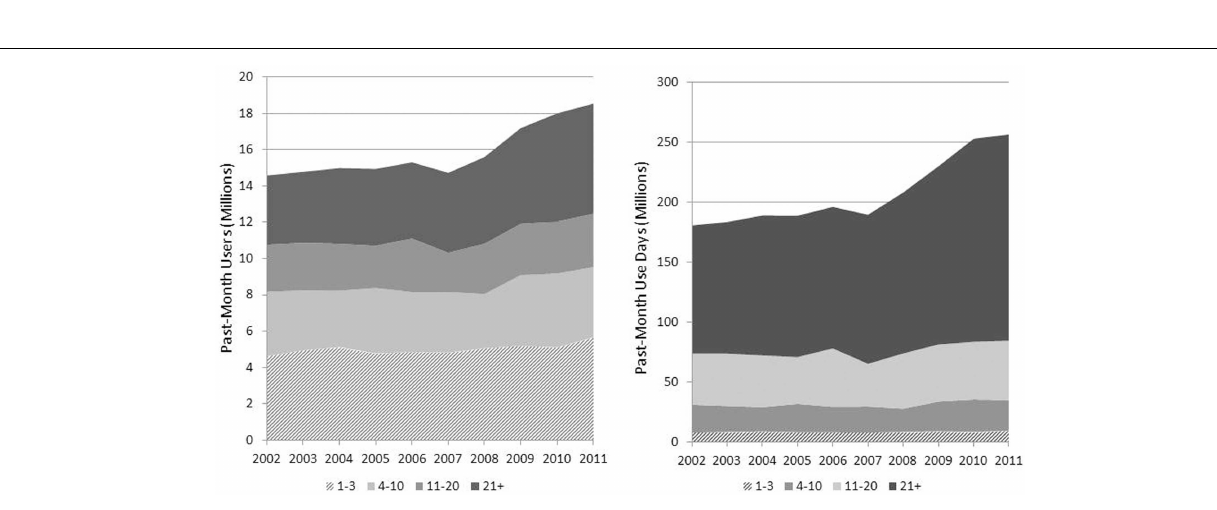
FIGURE 3 | Daily/near-daily users (21days or more in the past-month) represent a minority of users yet are responsible for the majority of past-month use-days . Note: because NSDUH did not collect data about blunts in 2002 and 2003, use-days may be underestimated for these